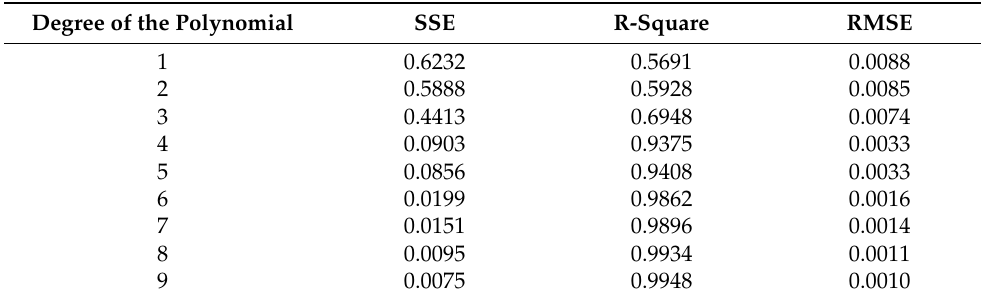
Figure 7. Curve fitting using polynomials of different degrees for the cross-section of S-LS. Table 7. Precision analysis of the different curve fitting polynomials used for the S-LS cross-section.